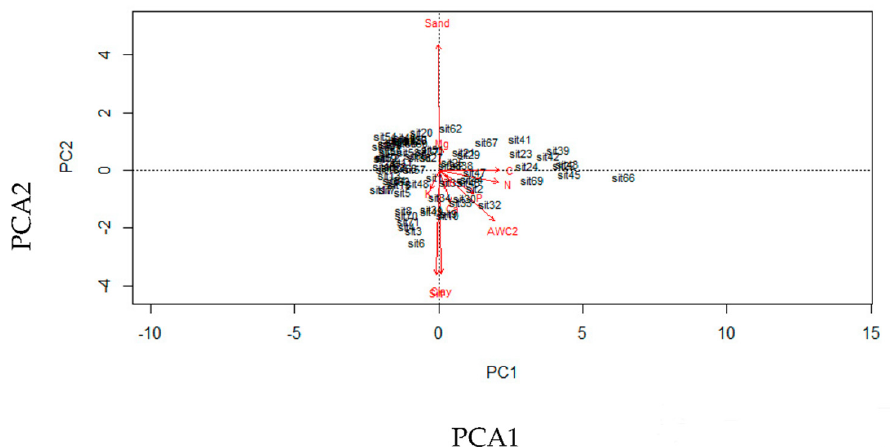
Figure A1. The Ordination analysis with all the factor related to the soil properties. First and second axes are used to summarize the soil property as organic matter (PCA1) and soil structure sand, clay and silt (PCA2). Stress: 0.1756, the first axis explained 75% of the total variance, with total carbon and nitrogen as the main factor, whereas the second axis explained soil structure as sand, silt, and clay, with 18% of total variance.